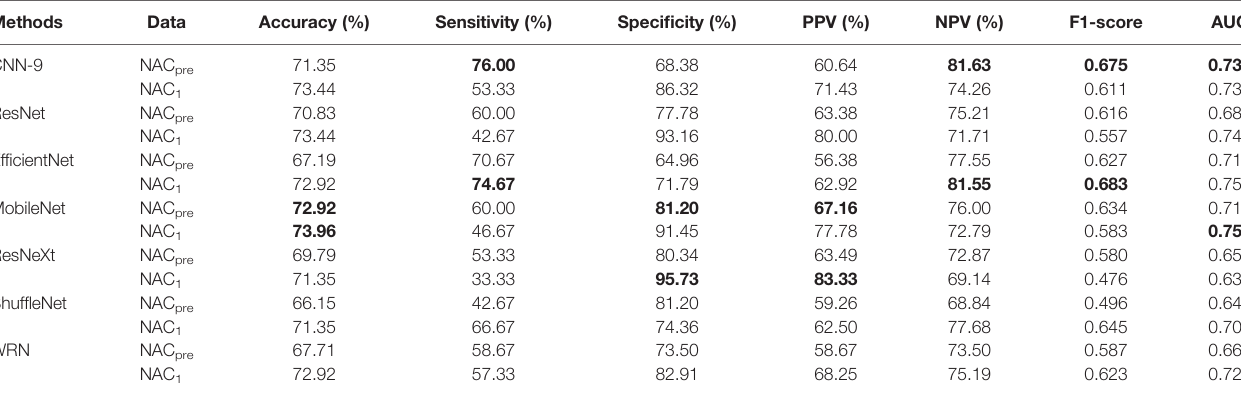
TABLE 9 | Comparison of CNN-9 and sophisticated DL models for single branch classi fi cation. Methods